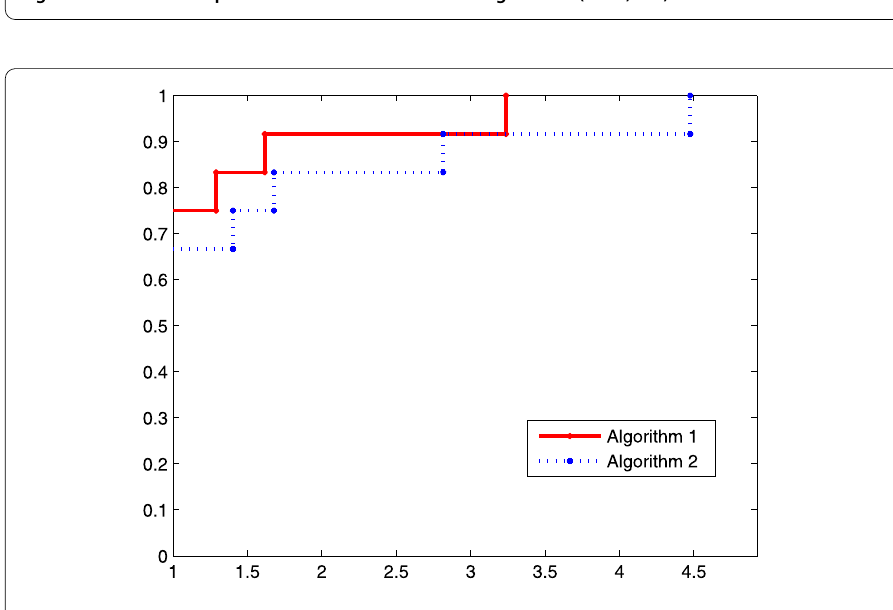
Figure 6 Performance profiles of the CPU time of two algorithms ( n =